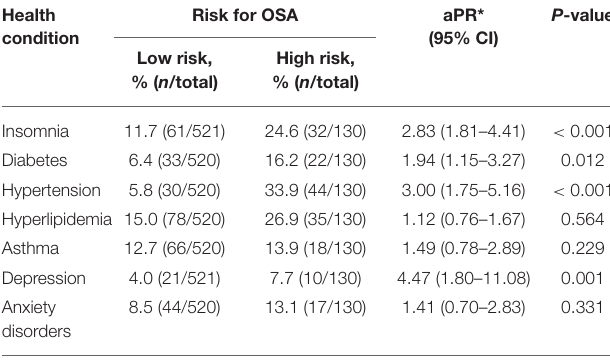
TABLE 3 | Associations of obstructive sleep apnea (OSA) risk with comorbid health